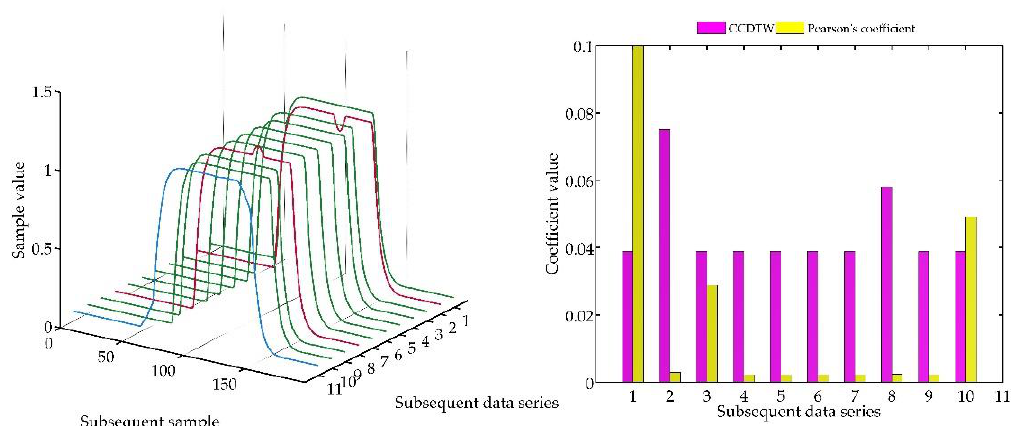
Figure 23. Simulation results obtained for disturbed non shifted charts № 2, № 8, and shifted non disturbed charts № 1, № 3, and № 10 for r ampl = 1.